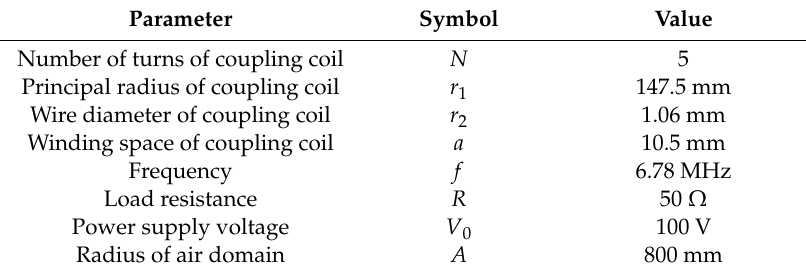
Table 1. Parameters of Symmetrical WPT